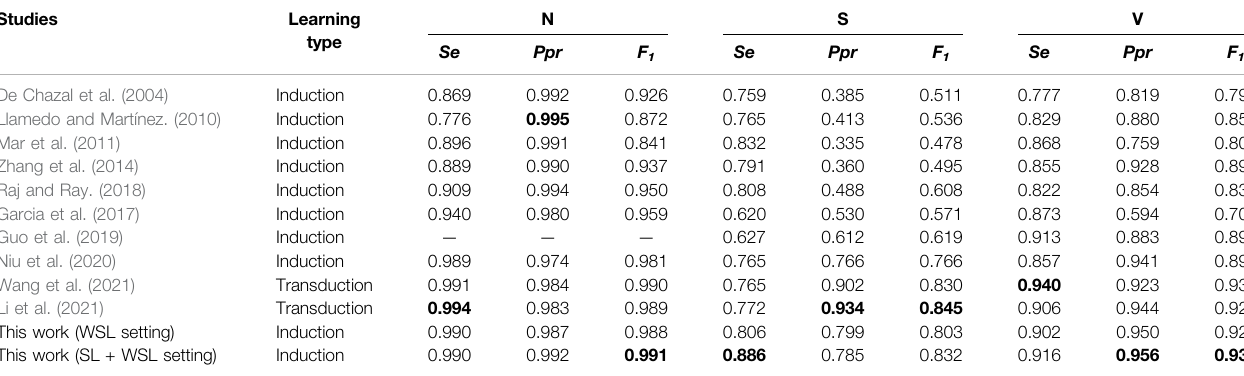
TABLE 4 | Comparison of our method with other studies on DS2 of the MITBIH-AR dataset. Studies Learning type De Chazal et al. (2004)